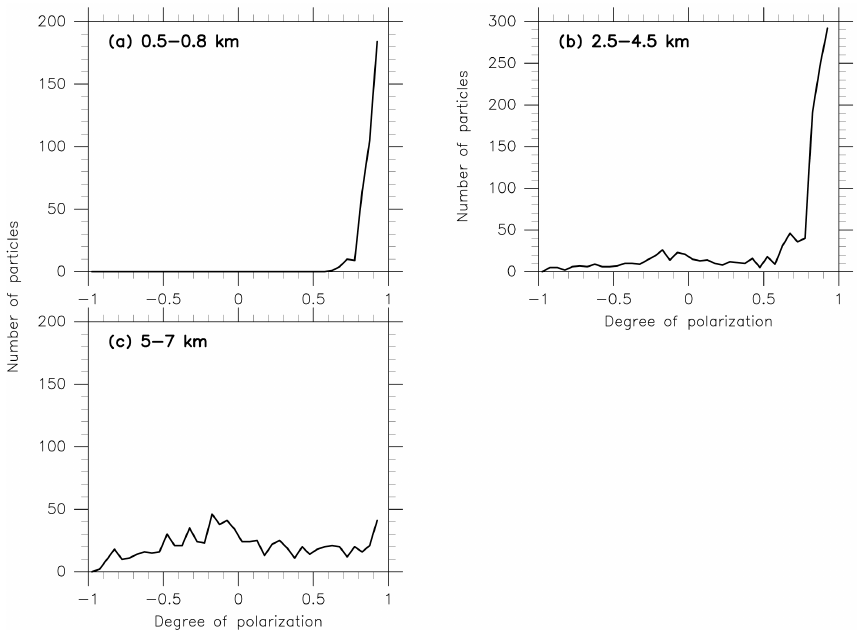
Figure 7. Frequency distribution of the degree of polarization (DOP) in 0.05 bins from the results shown in Fig. 6 at (a) 0.5–0.8km (water clouds), (b) 2.5–4.5km (mixed-phase clouds), and (c) 5–7km (ice clouds). Note that particles with I 55 values greater than 7.0V were excluded from the analysis, as such particles create a very large peak around zero for ice or mixed-phase clouds.